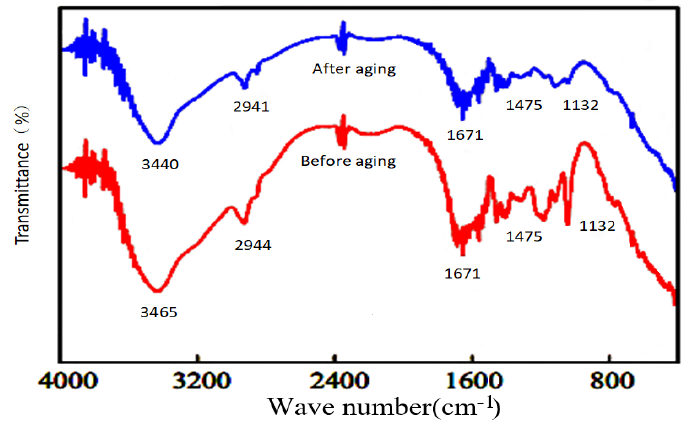
Figure 12. FTIR profiles recorded before and after aging.